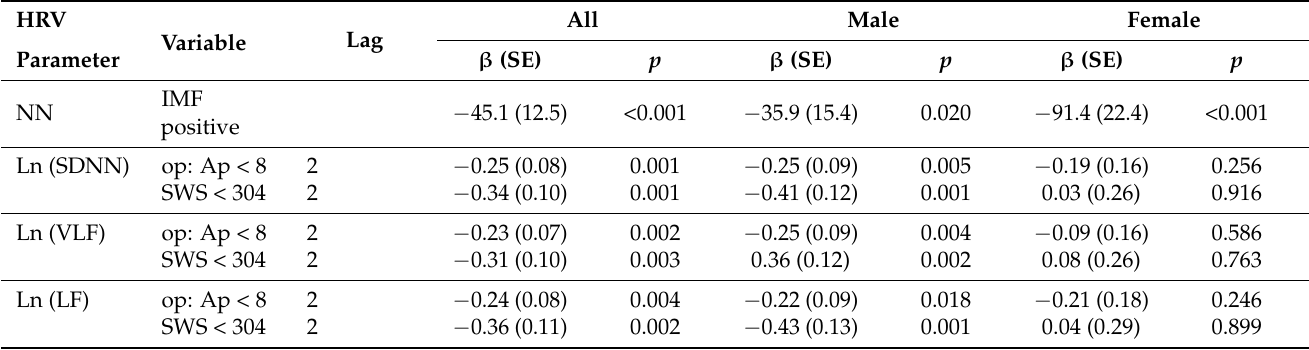
Table 2. Multivariate associations between space weather variables and